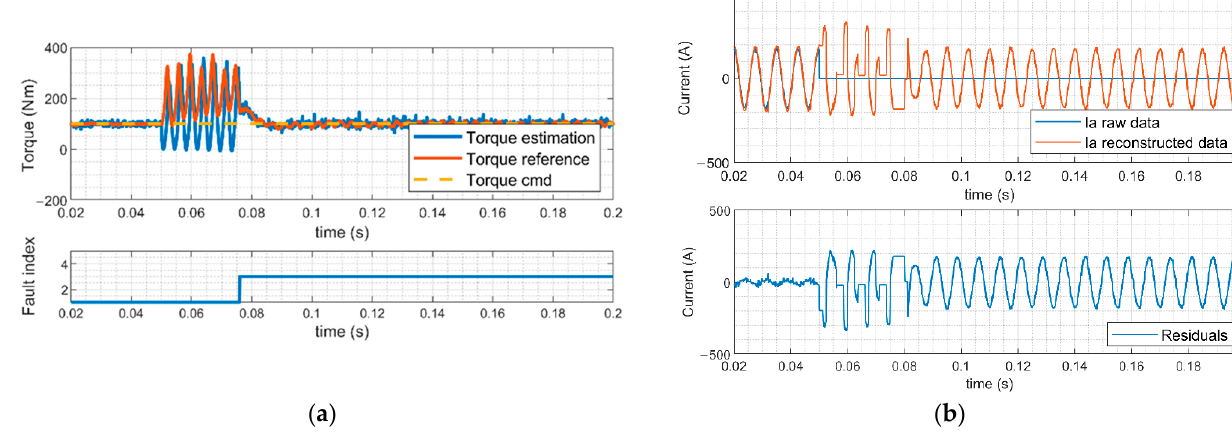
Figure 13. System response of phase A current sensor fault. ( a ) Estimated and reference values of torque; ( b ) phase A current signal and its residual.